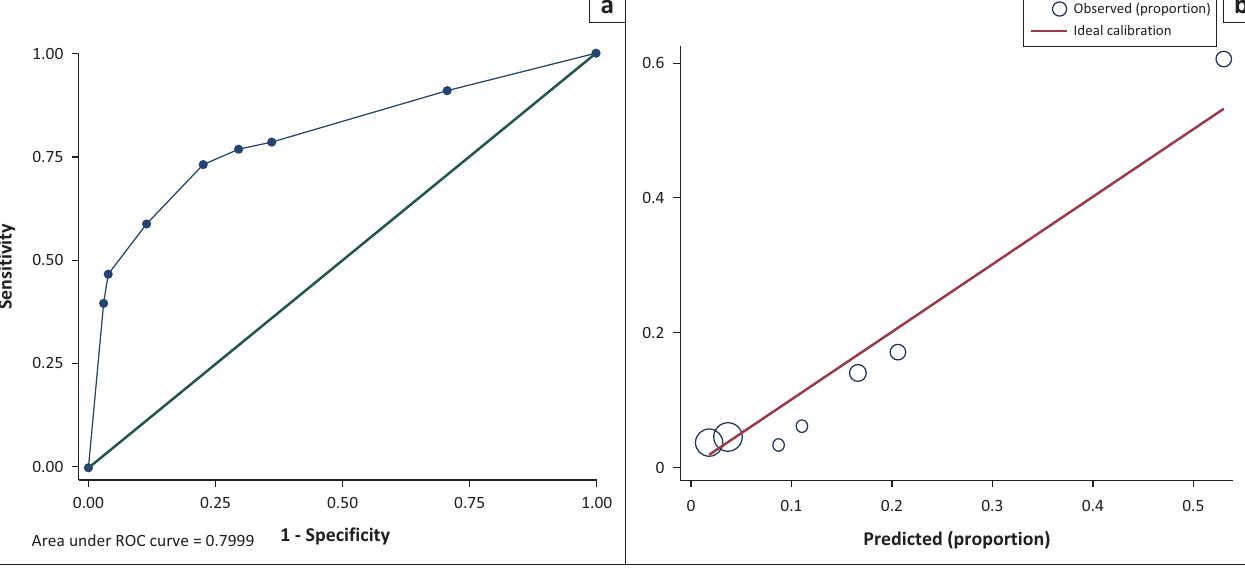
FIGURE 2: Oxygen saturation multivariable logistic regression model to establish a clinical prediction rule for the diagnosis of Pneumocystis jirovecii pneumonia (PJP) among 500 seriously ill HIV-infected participants presenting with a cough of any duration and one or more World Health Organization danger signs. (a) Calibration plot for the assessment of variables included in the oxygen saturation model. The line shows perfect calibration between observed and predicted PJP. (b) Receiver operating characteristics (ROC) of the oxygen saturation